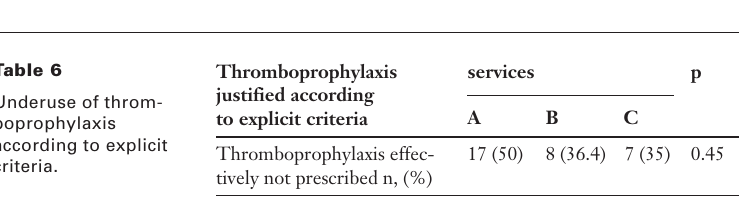
Overuse of throm- boprophylaxis according to explicit criteria.